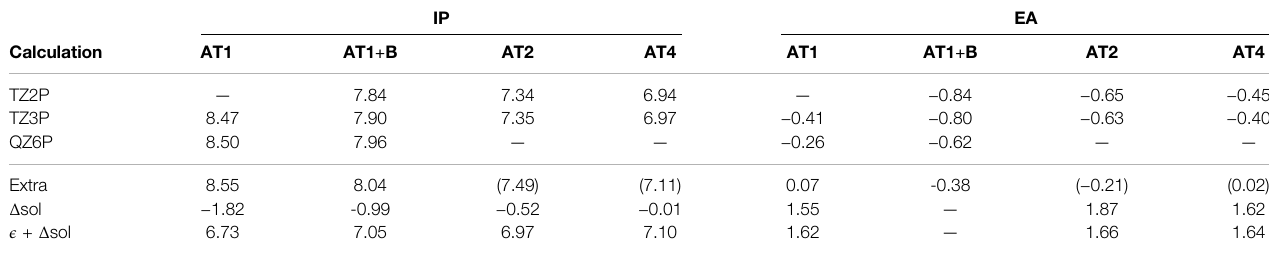
TABLE 2 | Ionization potentials (IPs) and electron af fi nities (EAS) of DNA fragments consisting of different numbers of adenine-thymine base pairs calculated with different basis sets and contributions of solvent from Δ BLYP calculations. Extra denotes extrapolation to the CBS limit based on TZ3P and QZ6P calculations and numbers in parentheses are obtained by adding the difference between ϵ CBS i − ϵ TZ 3 P i to the result obtained at the TZ3P level. Δ sol. has been calculated using COSMO. All values are in